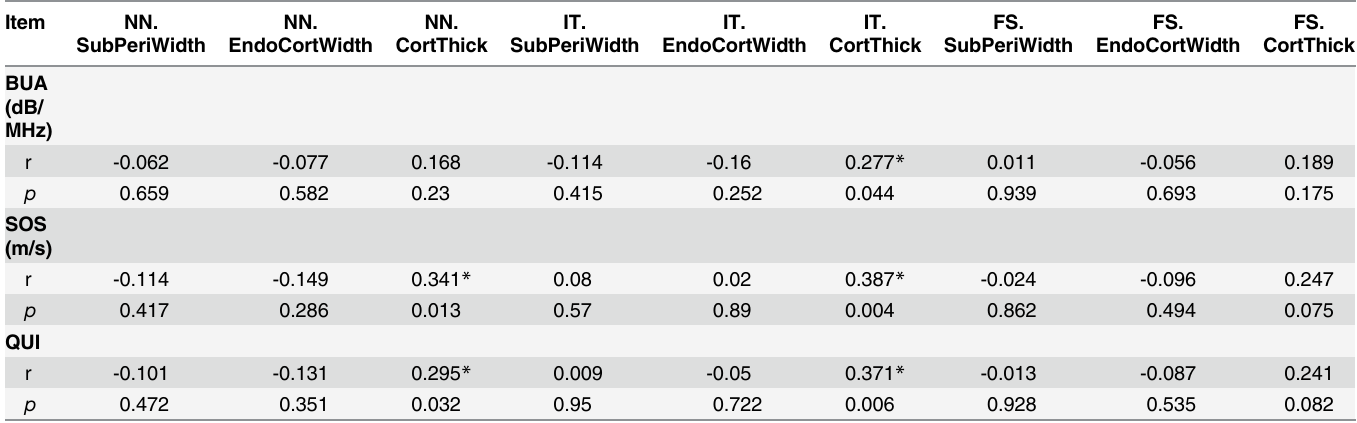
Table 4. Pearson ’ s correlation of the acoustic parameters with the HSA of the proximal femur cortical measurement